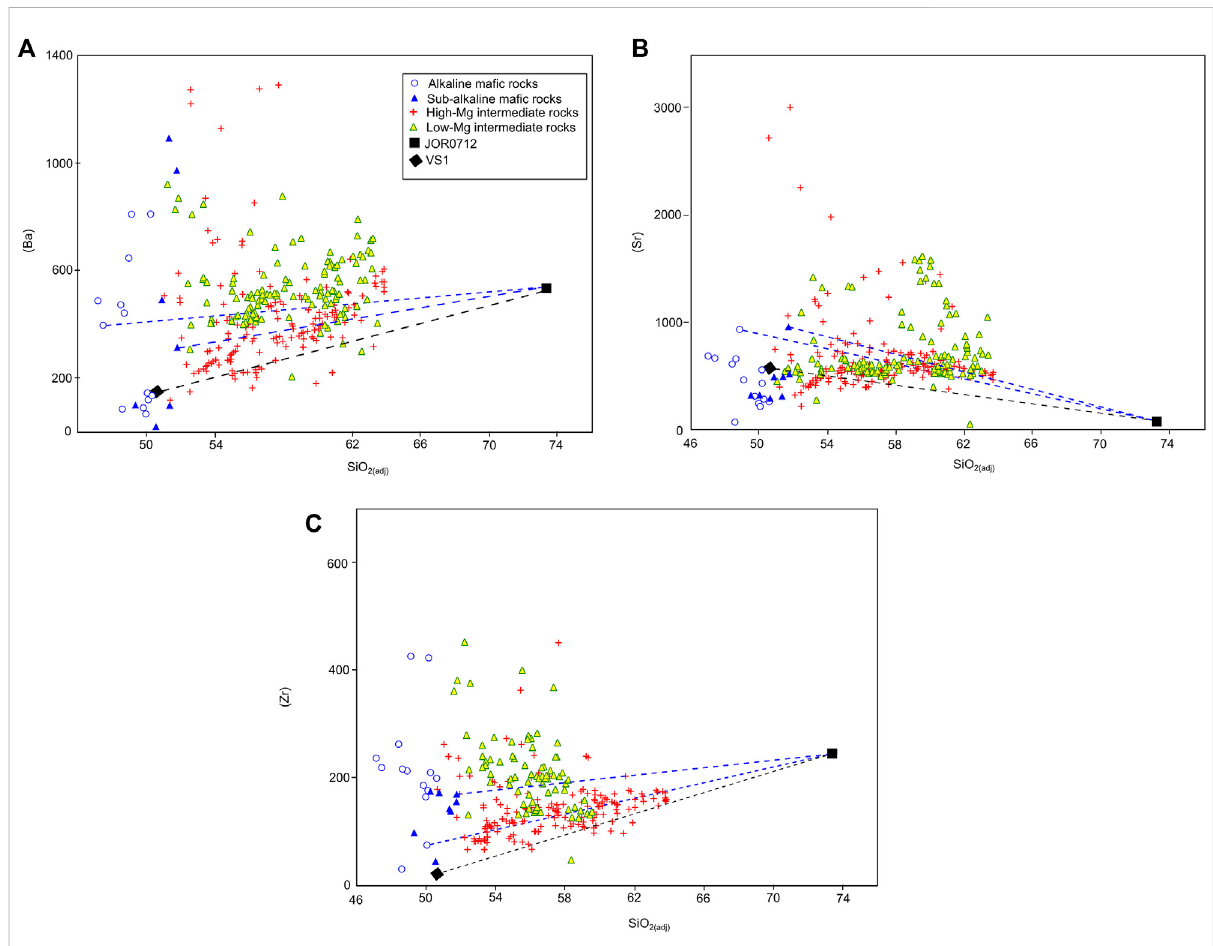
FIGURE 11 (A – C) Bivariate diagrams of SiO 2 vs. trace elements for low-Mg and high-Mg intermediate volcanic rocks from the MGVF. The black line represent mixing curve between granitic end-members. The blue line display mixing curves between alkaline and sub-alkaline with a granitic end- members. Given the overall compositions of ma fi c rocks, one or multiple ma fi c melts could be involved. The granitic samples (JOR0712 and VS.1) showarelativelysimilartrendtointermediatevolcanicrocks,suggestinglowdegreesofassimilation.Thelow-Mg intermediaterocksdisplayan increasewithSiO 2 incrementssuchinSrandBa,whichsuggestsfractionalcrystallization,whereasthatinZrvs.SiO 2 diagramdisplaysadecreasewith spread trend with SiO 2 increments. The high-Mg intermediate rocks show a from constant to increase in trace element with the SiO 2 increments, which suggests that fractional crystallization was not dominant; hence, a crustal assimilation could be